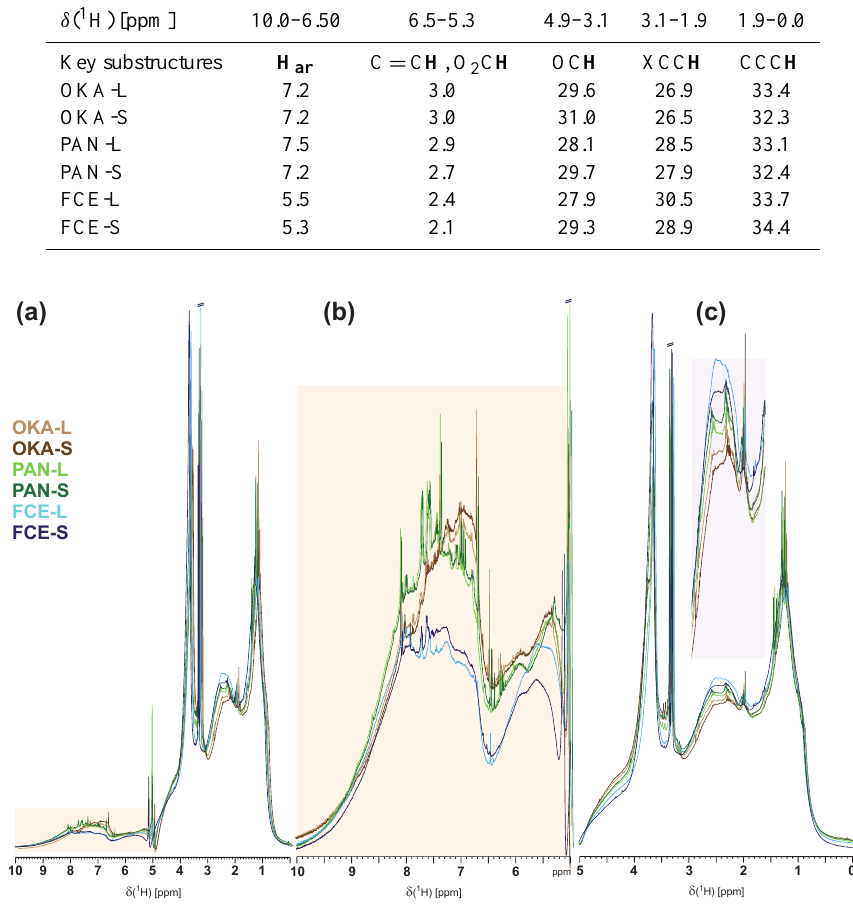
Table 2. 1 H NMR section integral for key substructures of natural organic matter (SPE-DOM) as computed from 0.001 1 H NMR bucket NMR integrals (see Fig. S2); owing to distribution of HSQC cross-peaks, the distinction between aromatic and olefinic molecules was placed at δ H = 6.5ppm (see Fig. 4).